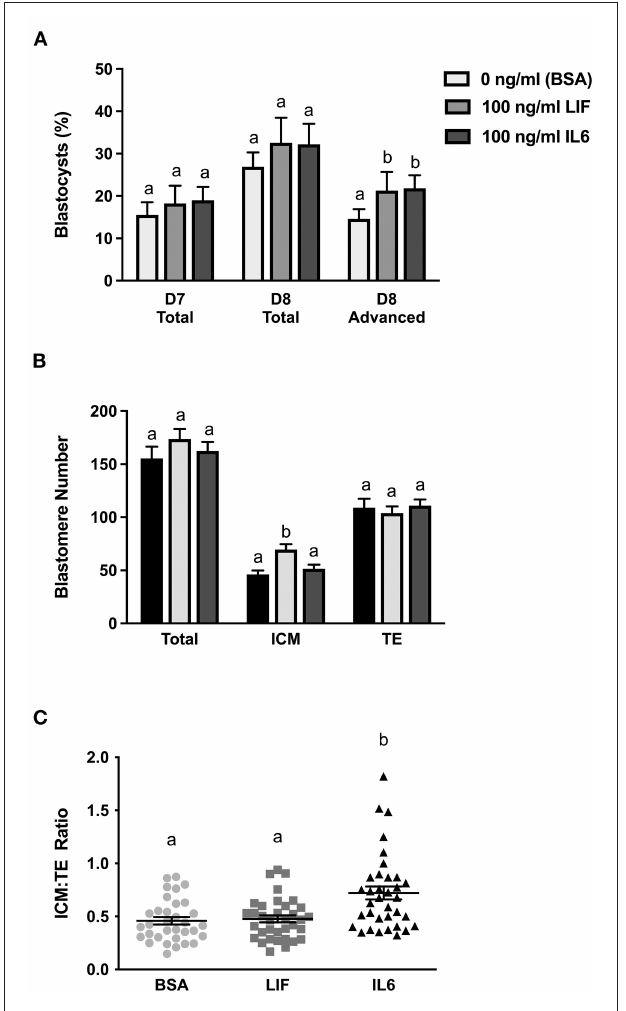
FIGURE 1 | Comparison of LIF vs. IL6 supplementation on blastocyst formation ( n = 18–32 zygotes/drop; 2–4 drops/treatment/replicate; 8 replicates) and day 8 cell numbers ( n = 33–35 blastocysts/treatment over 7 replicates). (A) Effects of 100ng/ml IL6 or 100ng/ml LIF supplementation on total blastocyst formation at day 7 and total and advanced blastocyst formation at day 8. (B) Effects of 100ng/ml IL6 or 100ng/ml LIF